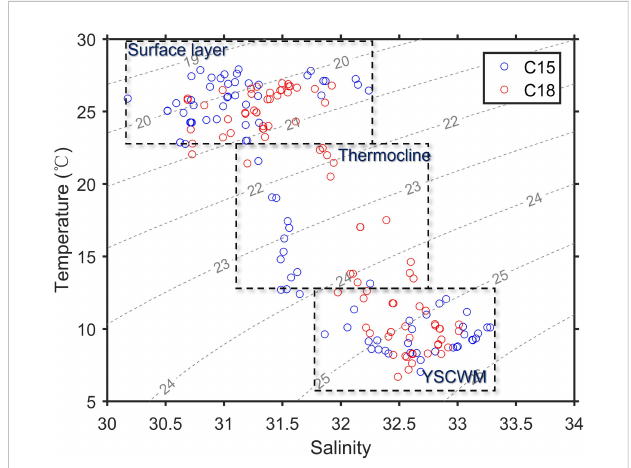
FIGURE 6 Temperature-Salinity (T-S) diagram during the two cruises (C15 and C18). The gray dash lines denote isopycnals (-1000 kg/m 3 ). The dash boxes mark the different water masses (surface, thermocline, and bottom